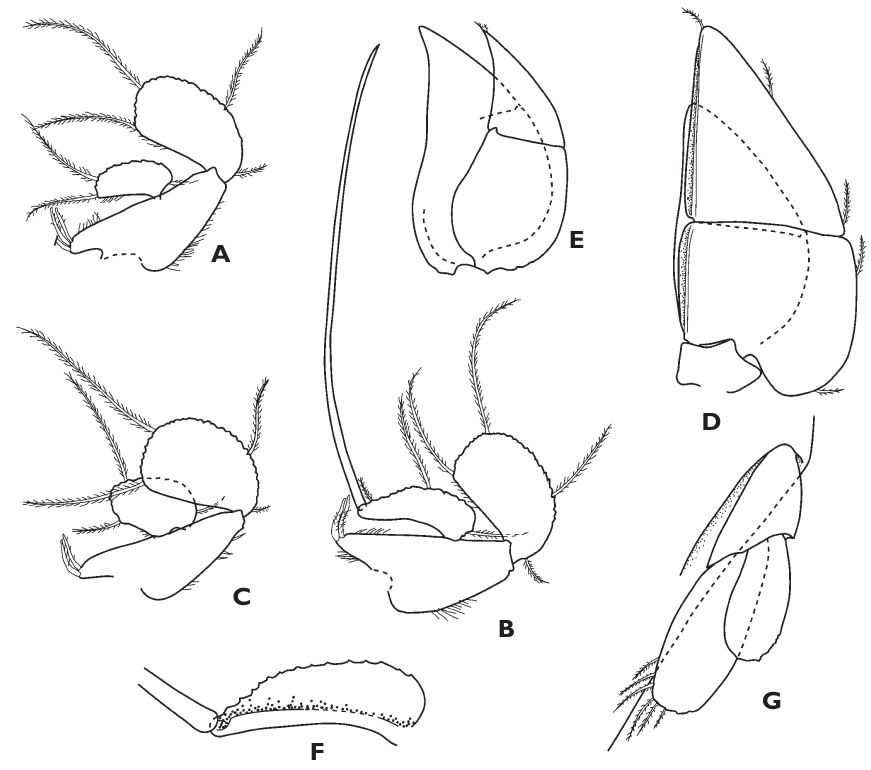
Figure 23. Myopiarolis systir sp. n. Paratype ♂ 11.4 mm, Is.6013. A–E pleopods 1–5 respectively F pleopod 2 endopod detail G